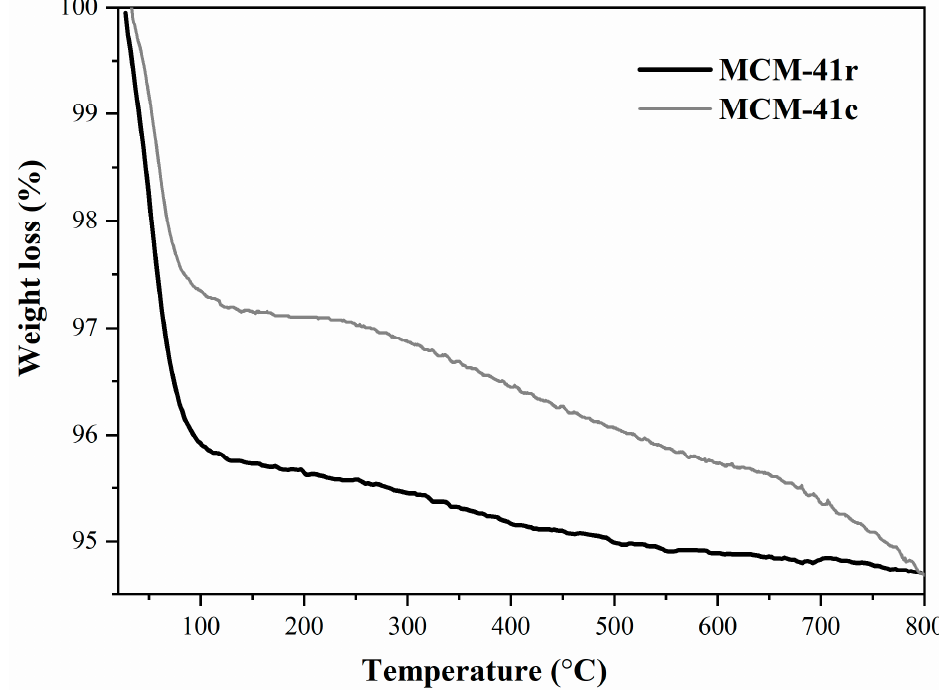
Figure 8. TG analysis of MCM-41 r and MCM-41 c.